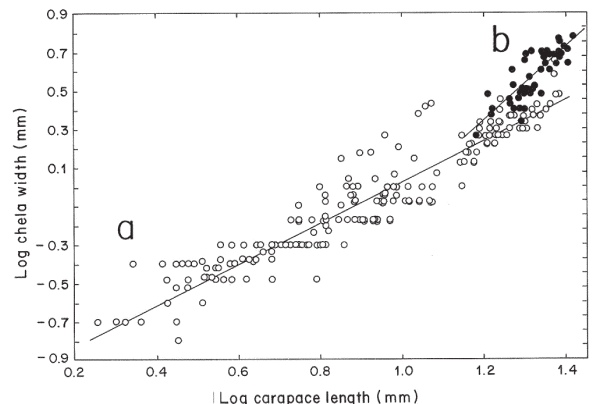
F IG . 5. – Relative growth of pre-pubertal (a) and post-pubertal (b) male Microphrys bicornutus in Buchuaco